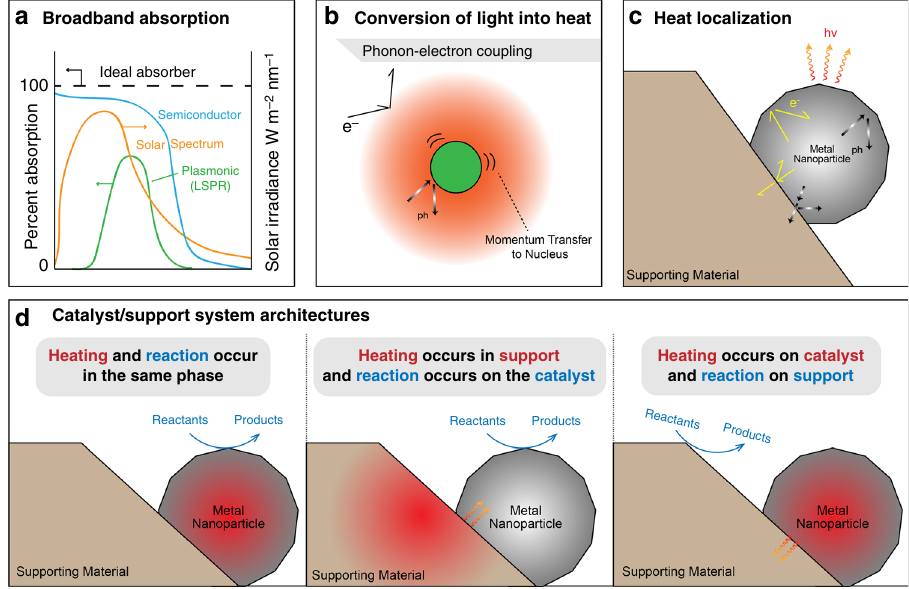
Fig. 3 Key concepts and examples of photothermal methanation architectures. a Schematic representation of the light absorption spectra of semiconductors and plasmonic metals in comparison to the solar emission spectrum. b Light-to-heat conversion: photo-excited electrons (e − ) interact with atomic nuclei, possibly generating phonons (ph). c Mechanisms of heat transfer within a particulate catalyst. Heat can be localized in catalyst nanoparticles by inhibiting phonon and electron transfer from the nanoparticle to its support. Structural defects, as well as phase boundaries between the catalyst and support phases, inhibit phonon and electron transfer and are hence bene fi cial for heat localization. Properties such as thermal and electronic conductivity, size and shape of the catalyst/support systems govern nanoscale heat transfer. d Selected potential photothermal catalyst